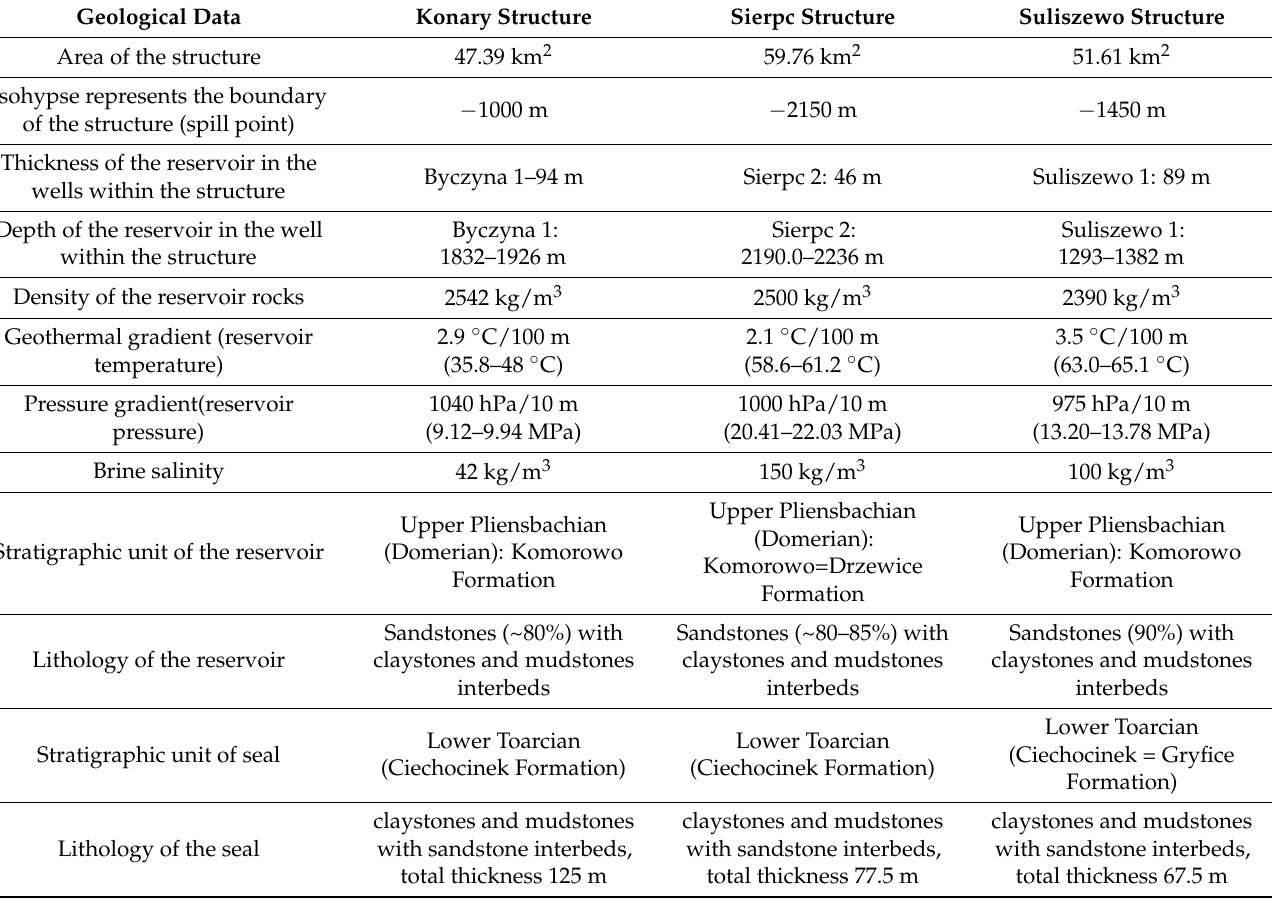
Table 1. Summary of the data assumed for CO 2 injection modeling for Konary, Sierpc, and Suliszewo structures (own work based on